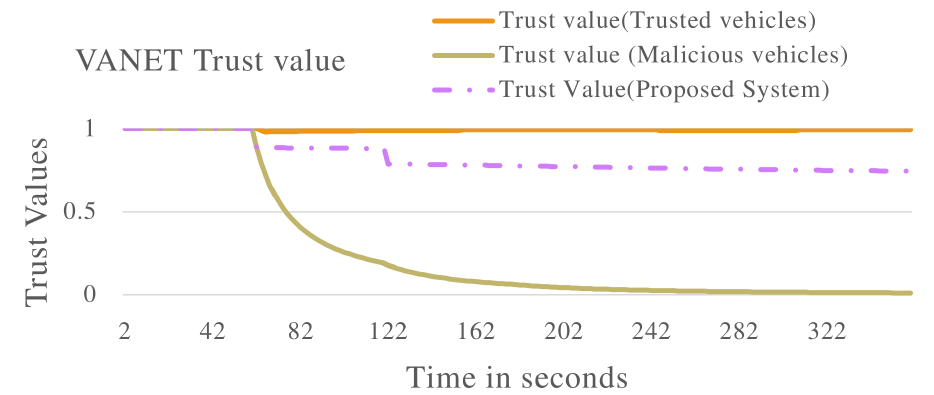
Figure 11. VANET trust value with multiple malicious vehicles including vehicles that are either delaying packets, dropping packets or both delaying and dropping packets.